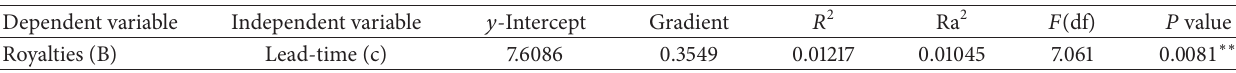
Table 8: Simple linear regression